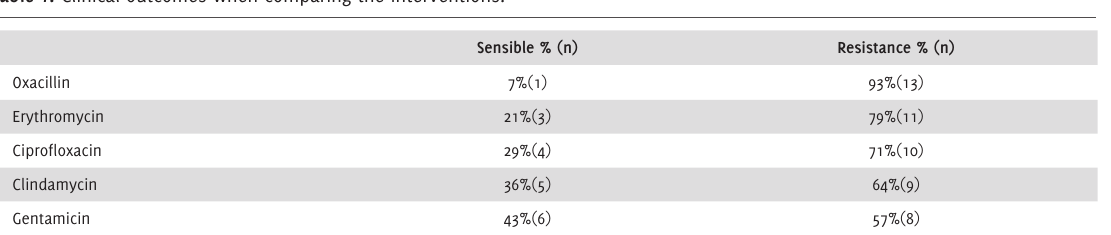
Table 1. Clinical outcomes when comparing the interventions.